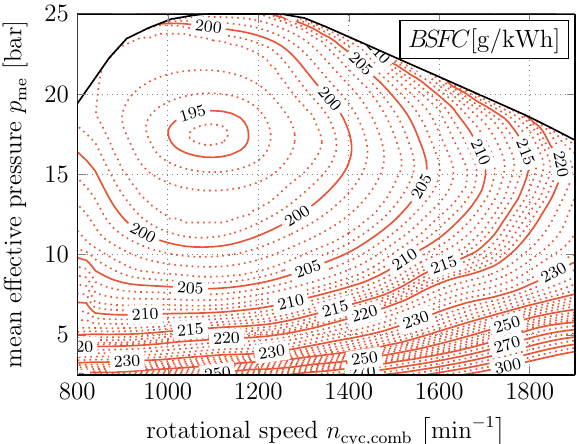
Figure 2. Brake specific fuel consumption map over mean effective pressure and rotational speed of the combustion engine. For this, a typical map for large diesel engines was used and scaled to an actual minimum fuel consumption value of